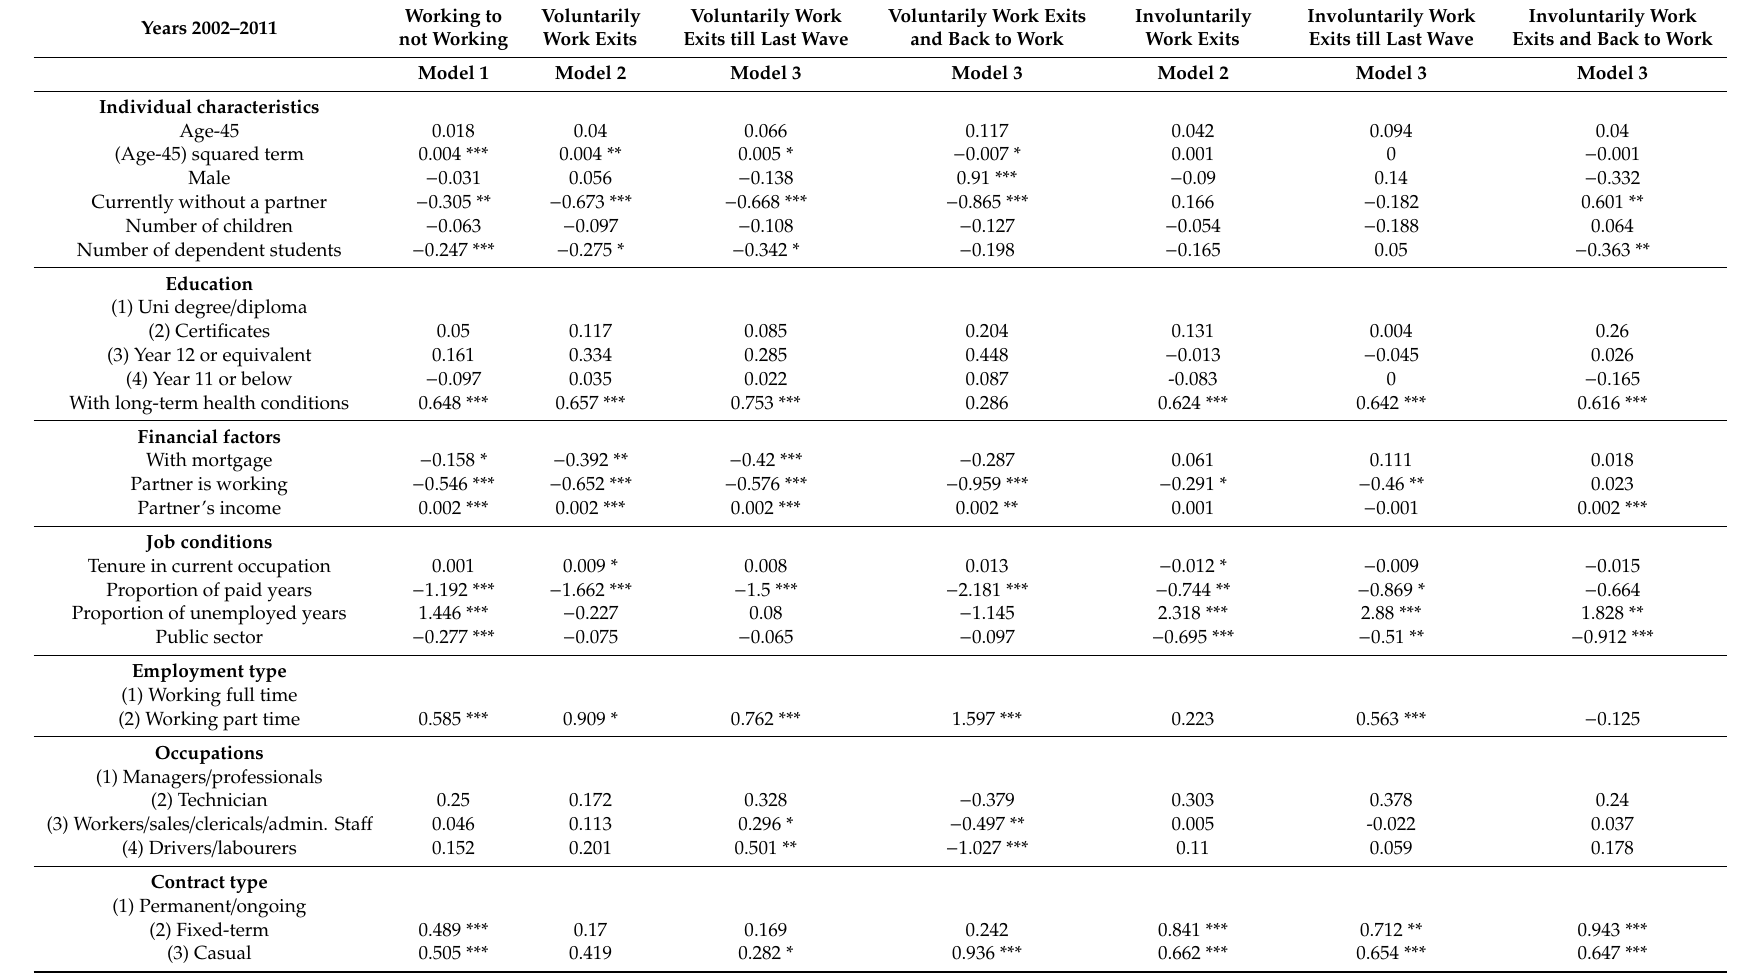
Table 3. Estimated coe ffi cients and significance levels for all predictors of workforce